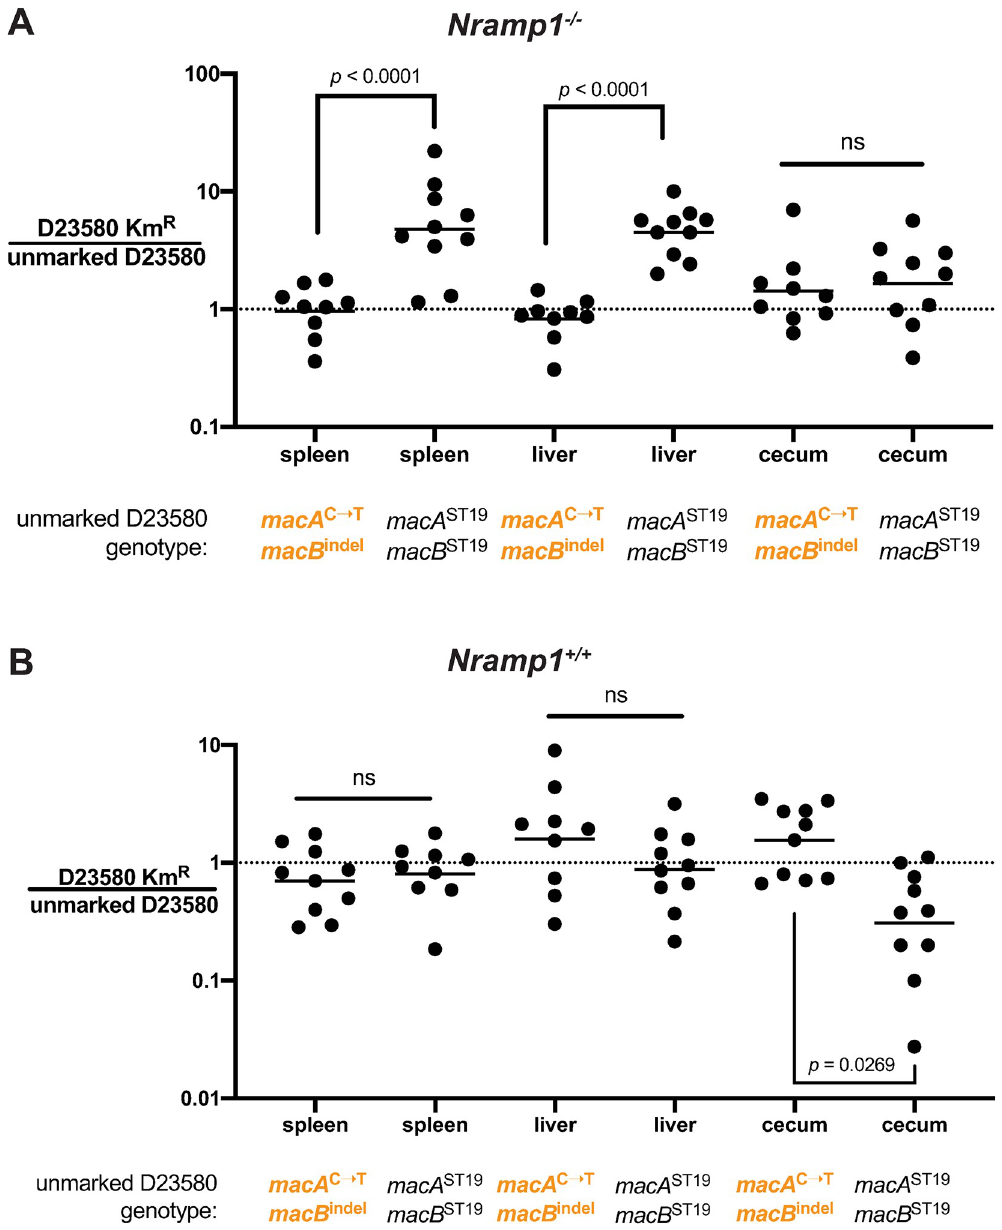
Fig 6. Host Nramp1 genotype alters the utility of the D23580 macAB genotype during systemic infection. Isogenic competition of a kanamycin-marked D23580 with parent D23580 or D23580 macA ST19 macB ST19 in (A) Nramp1 -/- C57BL/6J mice or (B) Nramp1 +/+ C57BL/6J mice, day 3 post oral infection after streptomycin pre-treatment. Two-way ANOVA with repeated measures on log-transformed data using Sidak’s post-test within organ, p values as indicated. Dots are competitive index values for individual mice with lines plotted at the geometric mean. See S2 Fig for CFU/g values.